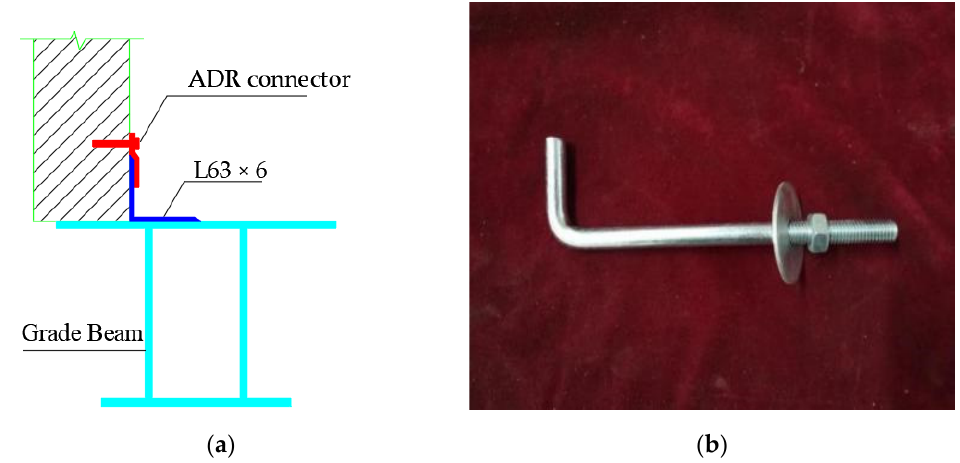
Figure 1. Connector schematic: ( a ) schematic of ADR connector; ( b ) schematic of external hook head